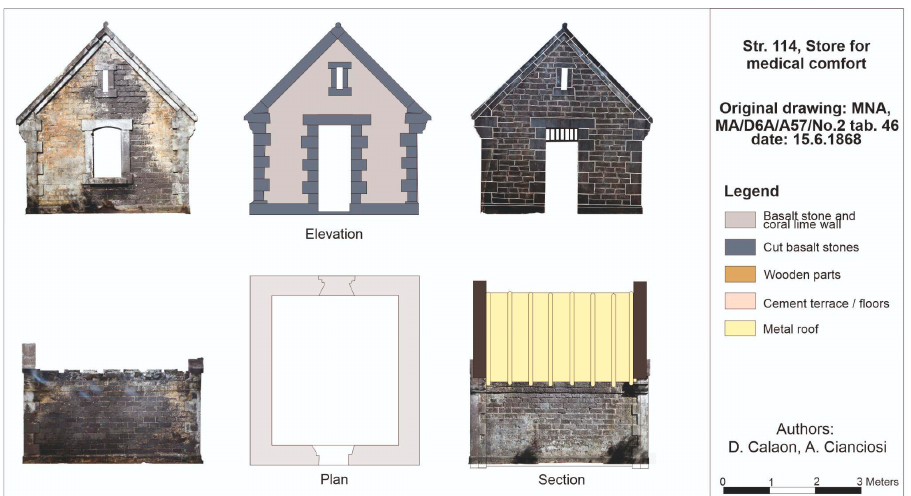
Figure 10. The store for medical comfort: photogrammetric orthomosaic image and redrawn archival architectural plan.